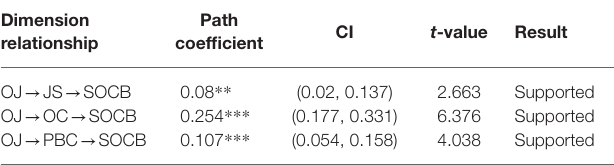
TABLE 7 | Indirect